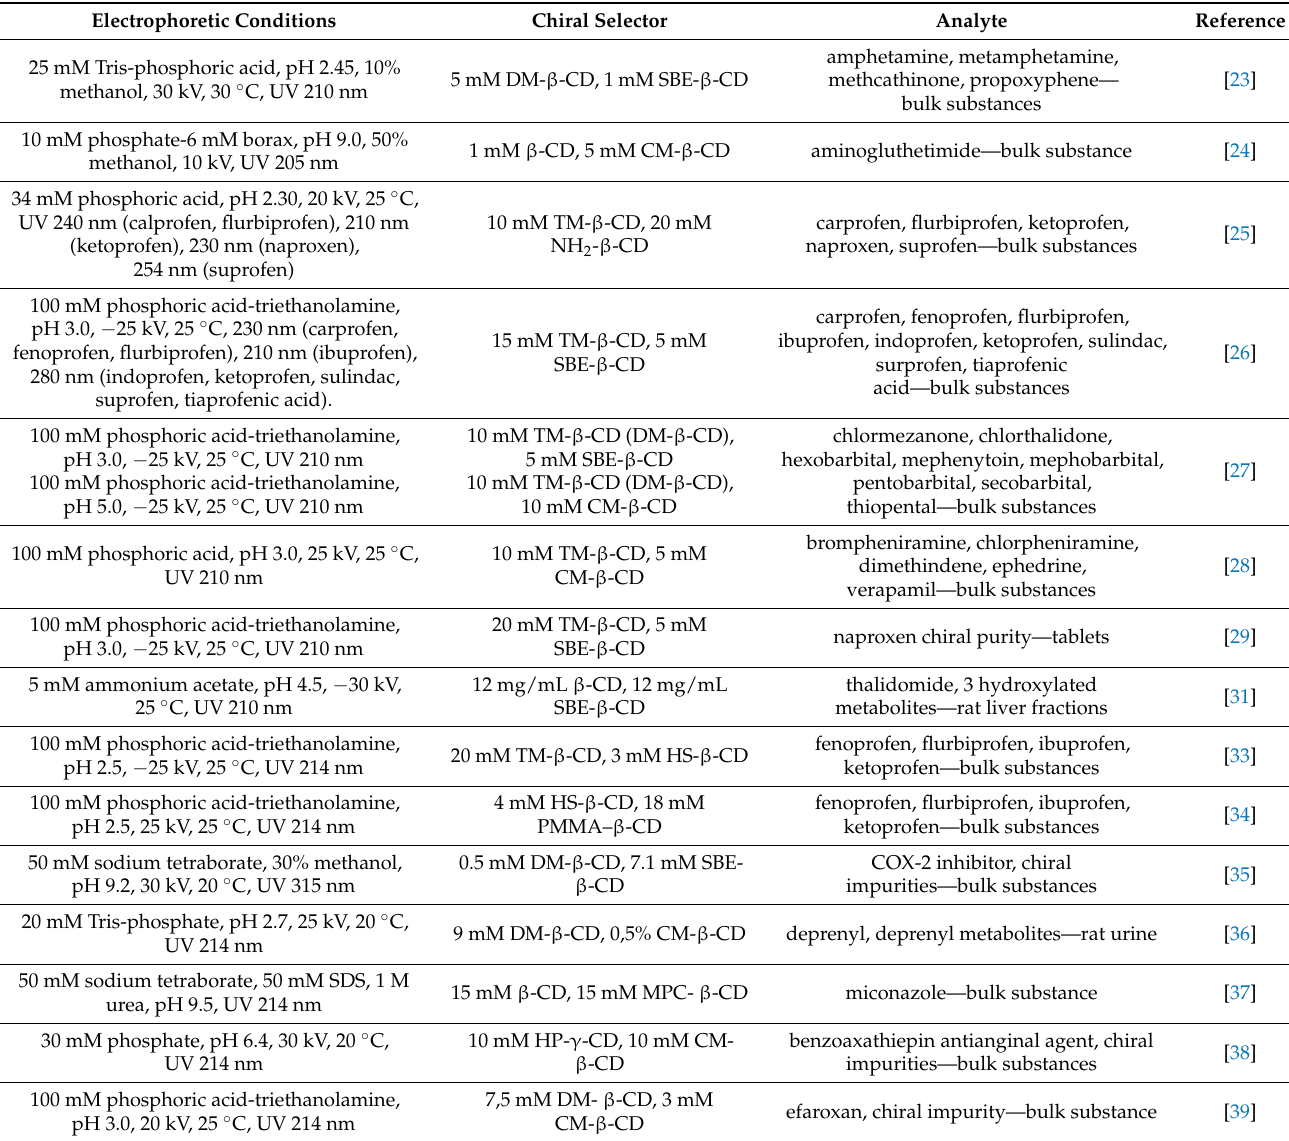
Table 1. Electrophoretic conditions for the enantioseparation of drugs using dual cyclodextrin systems. Electrophoretic